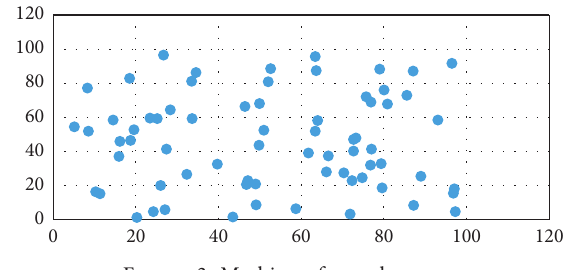
Figure 3: Meshing of sample space.